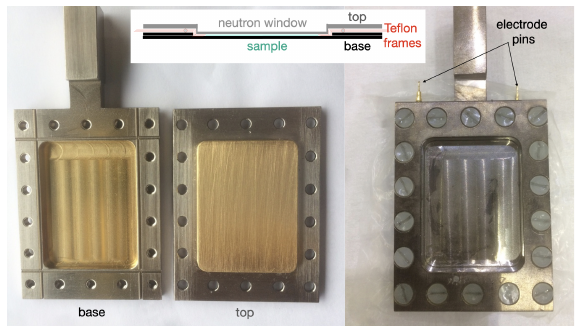
Figure 1. left photo: gold coated sample holder: bottom part (l.h.s.) and top cover (r.h.s.); right photo: filled sample holder with Nylon screws and electrode pins on top. Inset: schematic view how the sample is squeezed between base and top plate and how the 3 thin Teflon foils are